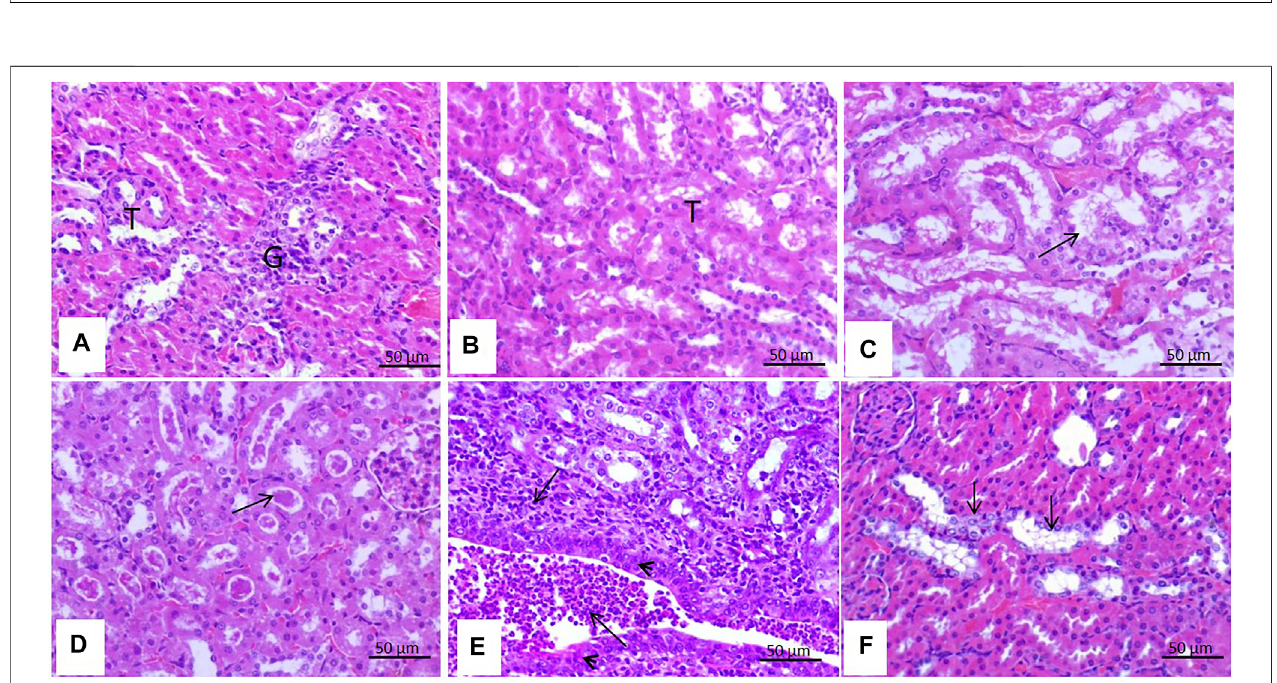
FIGURE 4 | Effect of malathion on the kidneys. (A,B) Kidneys of control rats and those treated with malathion for 24 h appeared with normal renal tubules (T) and glomeruli (G). (C) Rats treated with malathion for 21 days showing a moderate degree of vacuolar degeneration (arrow) in the lining epithelium of the renal tubules, (D) presence of proteinaceous casts (arrow) in the lumens of renal tubules, (E) massive pyelonephritis with mononuclear cell in fi ltration (arrow) in the pelvis and squamous metaplasia (arrow head) of the renal pelvis lining epithelium, and (F) tubular basophilia (arrow) of the tubular lining epithelium.